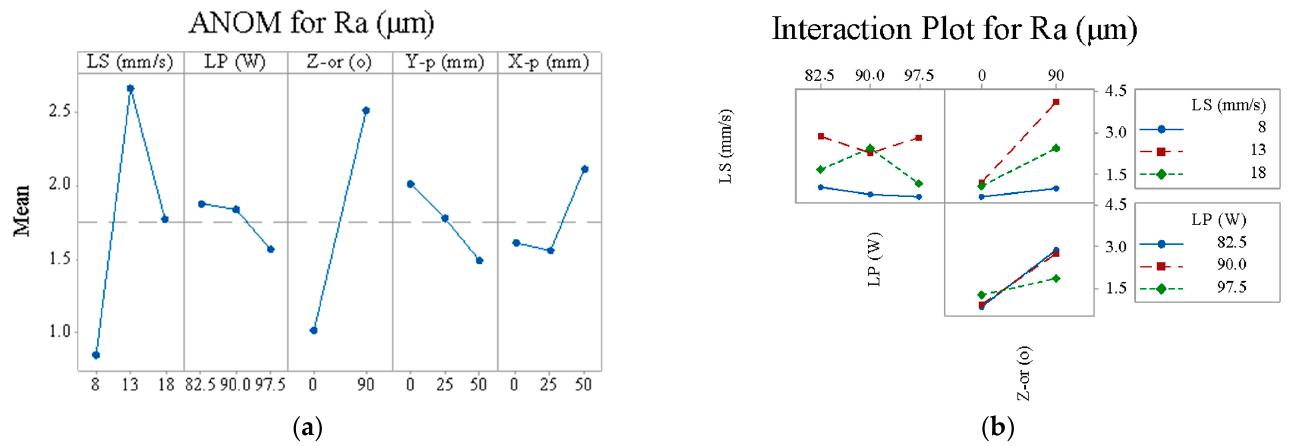
Figure 4. Process parameters plots: ( a ) ANOM plots for Ra and ( b ) interaction plots for Ra.